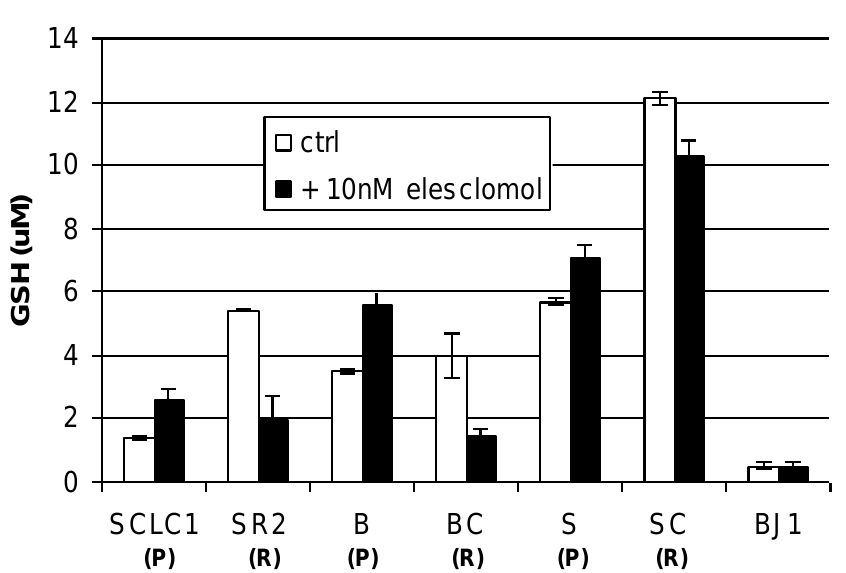
Figure 10. Total cellular of GSH in lung cancer cell lines treated with 10 nM of elesclomol for 24 h. Note: After treatment with elesclomol, the levels of GSH are decreased in all of the resistant cell lines (R) (Mean SD of three